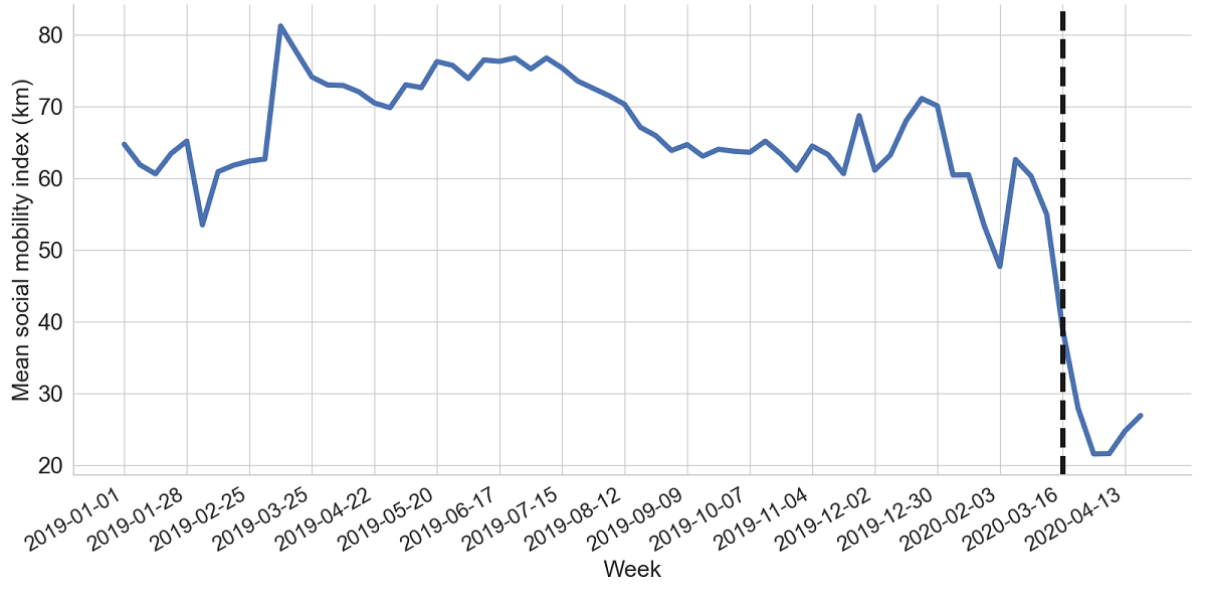
Figure 1. Mean social mobility index (kilometers) in United States from January 1, 2019, to April 27, 2020. Weeks with missing data are excluded from the